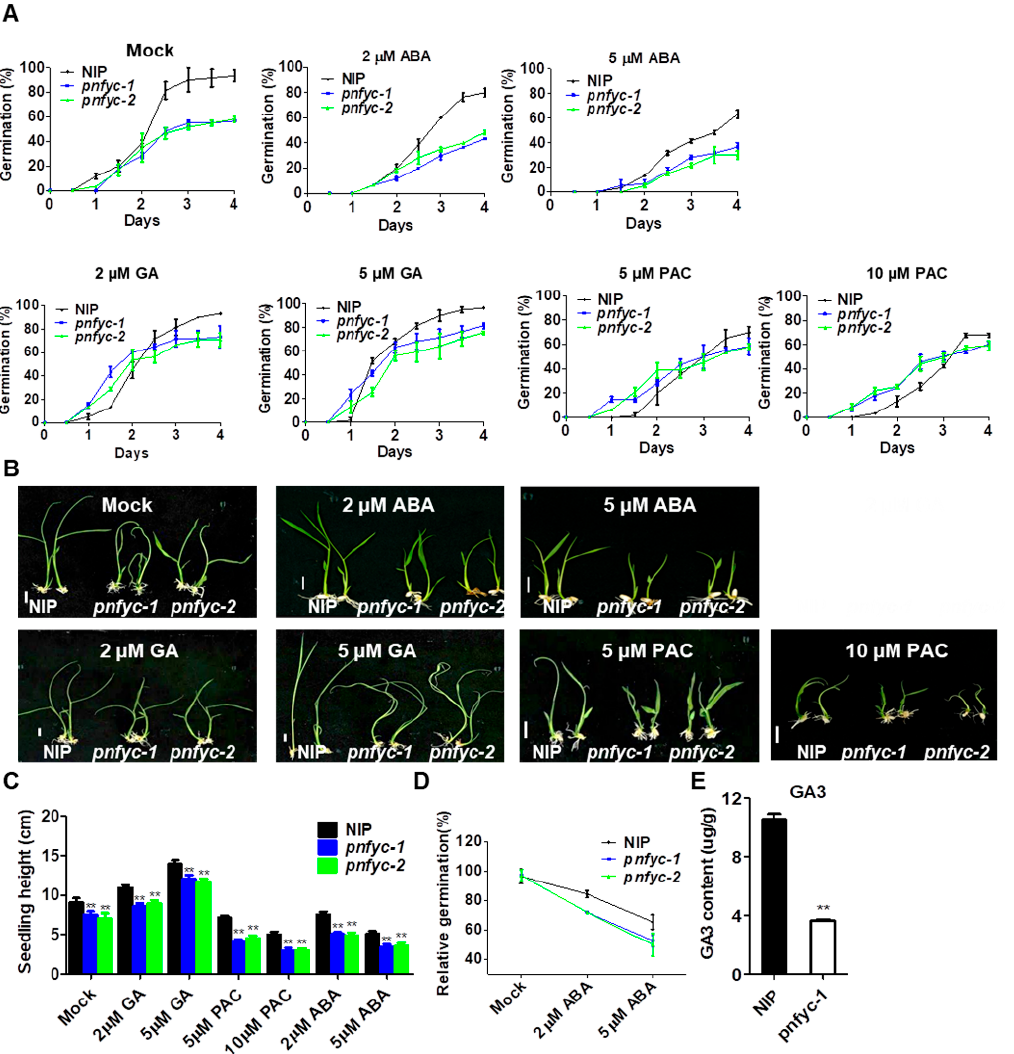
Figure 2. ( A ) The germination rate of NIP and pnfyc lines under different concentrations of exogenous hormones. ( B ) The plant morphology of NIP and pnfyc lines treated with different exogenous hormones at 7 days after germination. ( C ) The seedling height of NIP and pnfyc lines under different exogenous hormones at 7 days after germination. Bar = 1 cm. ( D ) The relative germination of the NIP and pnfyc seeds under ABA treatments were determined after 4 days and expressed as a percentage of those grown under ‘mock’ conditions. ( E ) Quantification of GA3 derivatives in NIP and pnfyc seeds germinated for 6 h was analyzed with liquid chromatography-tandem mass spectrometry. Data are shown as means ± SD of at least three biological replicates. (** p < 0.01 by two-tailed Student’s t -test). To test the involvement of the five NF-YCs in ABA and GA biosynthesis and signaling, we examined the transcription of the genes in the germinative seeds of various ABA or GA-related genetic lines by qRT-PCR. SAPK8 , 9 and 10 are core elements of ABA signaling, and over-expression of the genes conferred plants ABA hypersensitivity [33]. We found that NF-YC10 was significantly up-regulated by SAPK8 and 10 , while NF-YC8 and NF-YC12 were up-regulated by SAPK10 and SAPK9 , respectively. However, NF-YC9 and NF-YC11 were down-regulated in all the three OxSAPK lines (Figure 3A). In the GA-deficient mutant sd1 [34], the transcription of NF-YC8 , 9 , 10 and 11 were all severely repressed, indicating the five NF-YCs are highly responsive to endogenous GA level (Figure 3B). Taken together, we proposed that NF-YC8 , 9 , 10 , 11 and 12 may serve as key regulators mediating the balance of GA and